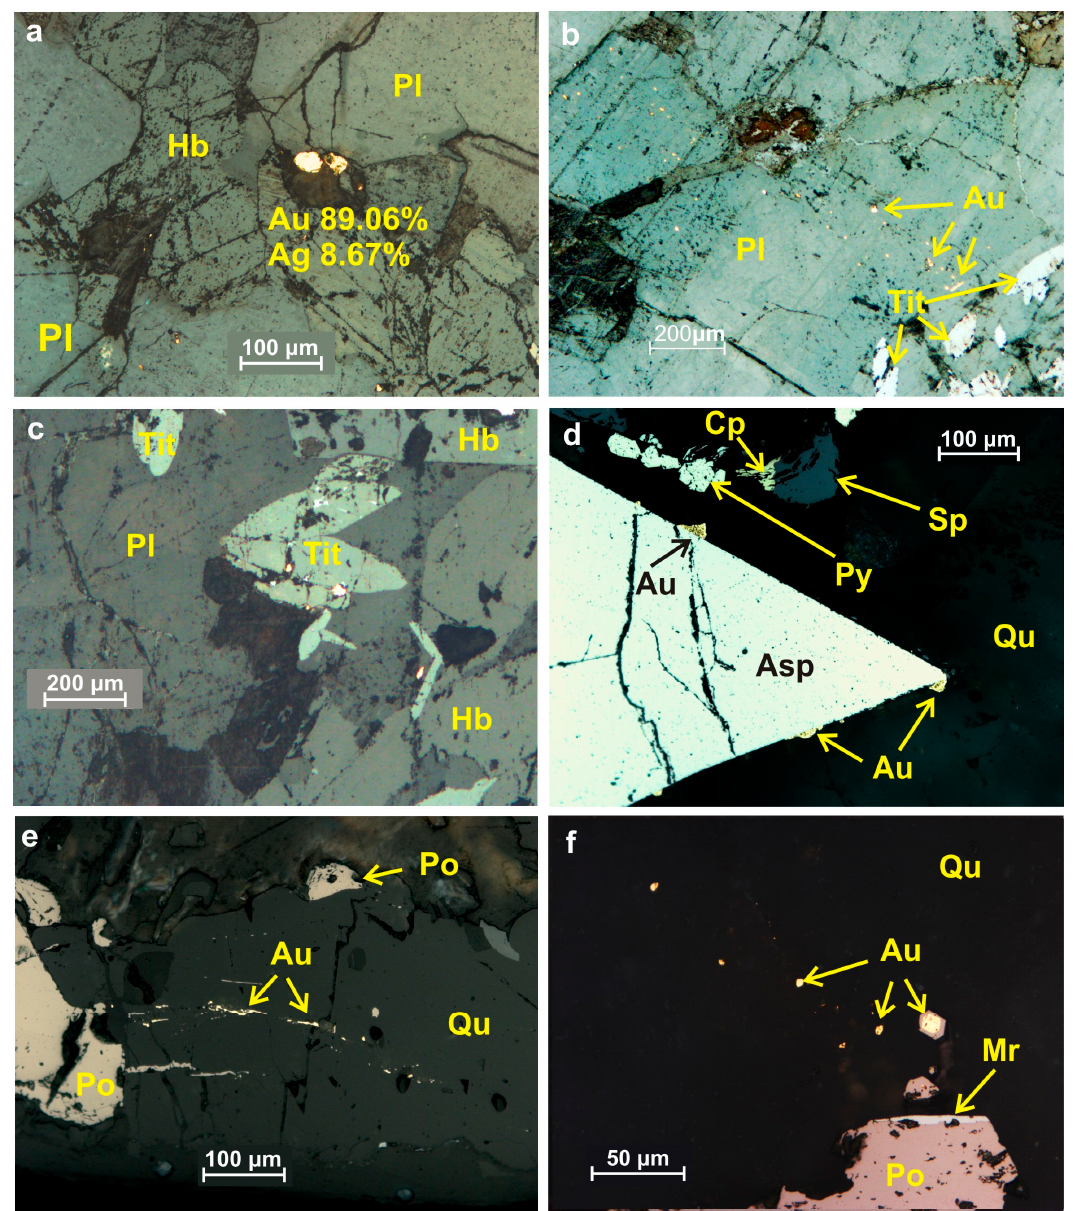
Figure 14. Gold in the Kichany occurrence, polished section photo, reflected light, one polarizer. ( a ) gold at the boundary plagioclase–hornblende, with the results of microprobe analysis, ( b ) a series of gold inclusions in plagioclase, ( c ) gold in titanite, ( d ) gold at the boundary of arsenopyrite metacrystal and quartz, ( e ) gold in fissures in quartz, and ( f ) gold in quartz, hexahedral gold grain is overgrown by pyrrhotite.